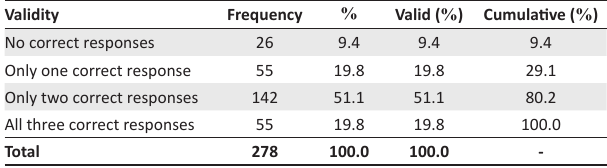
TABLE 4: Joint probabilities of answering financial literacy questions correctly.